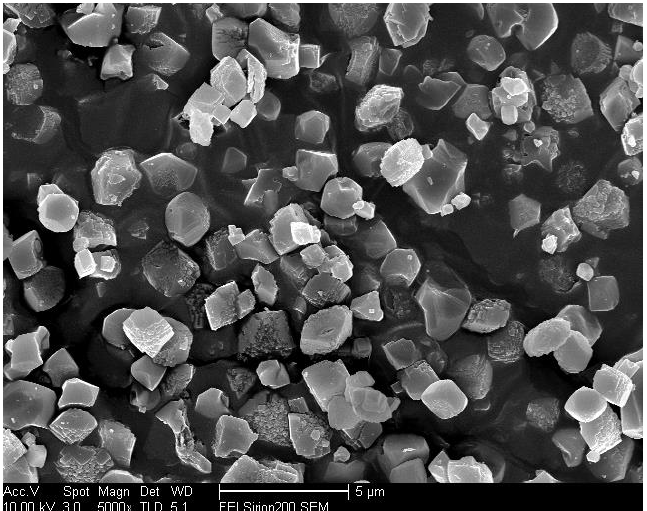
Materials 2019 , 12 , x FOR PEER REVIEW Figure 9. The SEM result of the as-prepared SSZ-13 using ground seeds with 1 h grinding.